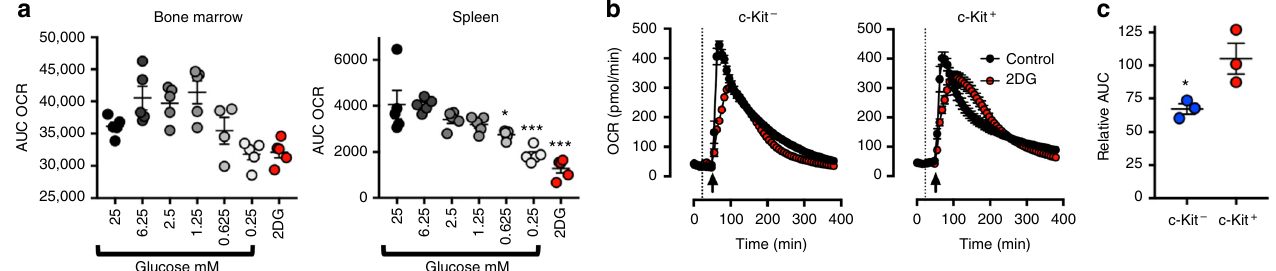
Fig. 3 Mitochondrial capacity aids ROS production in low glycolysis. a Area under the curve (AUC) oxygen consumption rate (OCR) (total oxygen consumption in pmol) of respiratory burst in bone marrow- and spleen-derived C57BL/6J neutrophils following stimulation with phorbol 12-myristate 13- acetate (PMA, 1 µ g/ml) in 0.25 – 25 mM glucose or following 2-deoxy glucose (2DG, 100 mM). Data ( n = 5 per group) were analysed by paired one-way ANOVA with Dunnett ’ s multiple comparison tests indicated, data represents two similar experiments. b Representative OCR traces from C57BL/6 bone marrow neutrophil subsets following stimulation with PMA (1 µ g/ml) (arrow) in the presence or absence of 2DG (100 mM) (dotted line). c Relative AUC OCR in neutrophil subsets from ( b ) following 2DG and PMA stimulation, when compared to PMA alone. Data ( n = 3 per group) were analysed by paired t - test, from two independent experiments. p Values *<0.05, ***<0.001. All error bars display mean ±